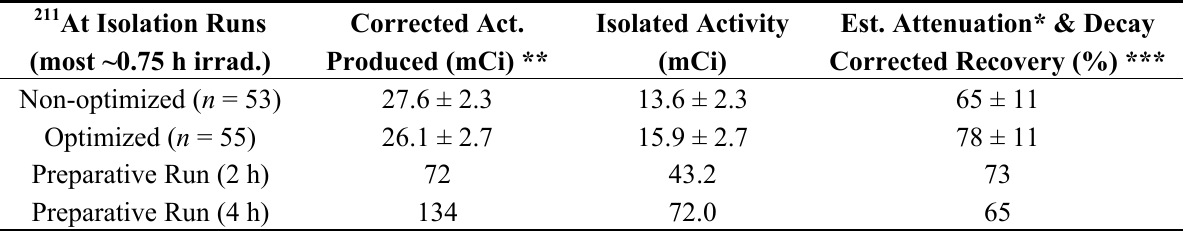
Table 3. Wet chemistry 211 At isolation yields corrected for decay and attenuation